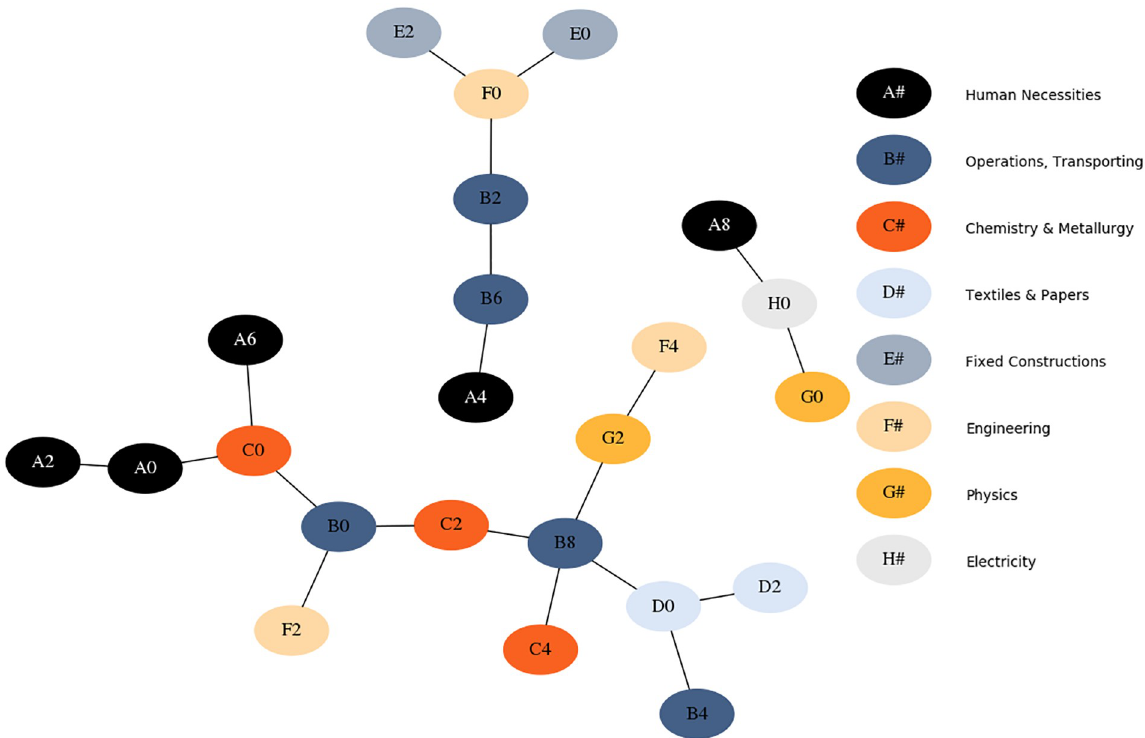
Fig 4. Minimal spanning forest of B . The nodes in the graph represent IPC subsections and are colored according to the section they belong to. Each node is connected to the technological field which is linked to it with the highest weight. The color pattern shows that the driver for the co- occurrence of technologies is not technologies themselves, but a hidden layer